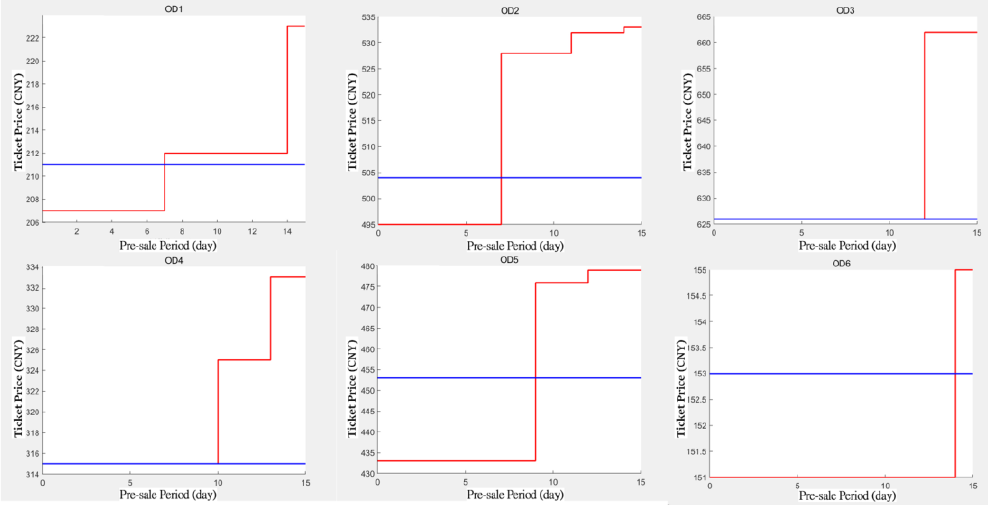
Figure 9. Ticket price change in different OD sections during pre-sale period.